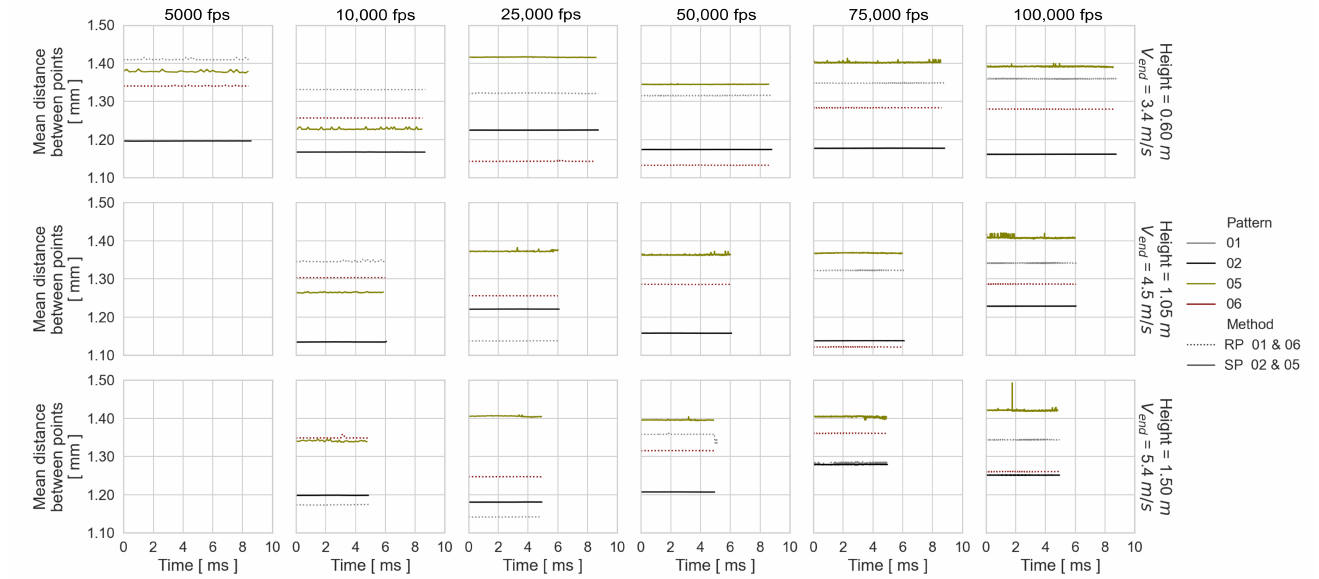
Figure 12. Mean distance between points per time step and object falling recording